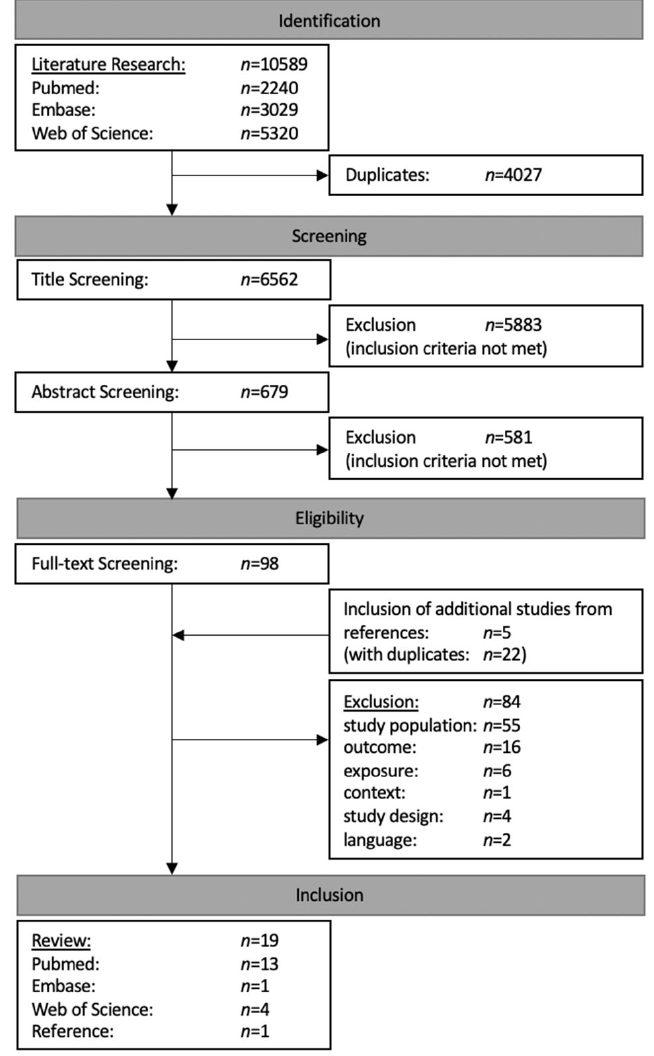
Figure 1. Flow chart of literature research and screening process.